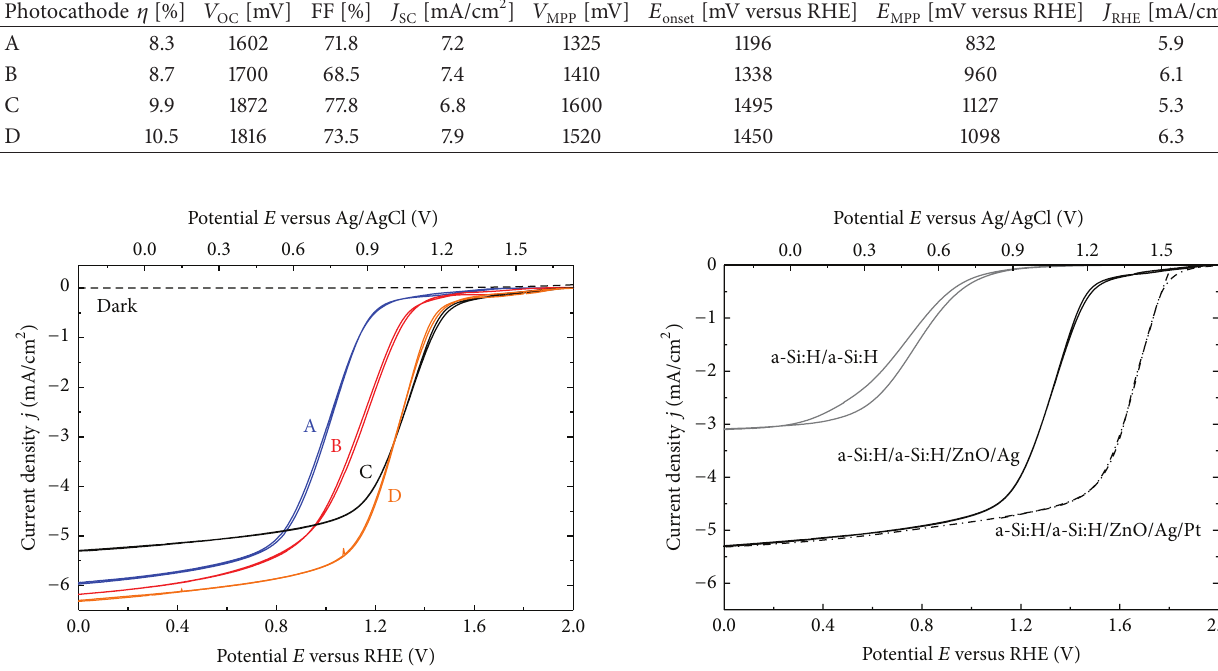
Figure 10: Cyclic voltammetry measurement of a-Si:H/a-Si:H pho- tocathodes with no metallic back contact (solid grey curve), with ZnO/Ag back contact (solid black curve, photocathode C from Table 3) and with ZnO/Ag/Pt back contact (dashed curve), in 0.1M H 2 SO 4 solution (pH 1) under 100mW/cm 2 illumination intensity at a scan rate of 30 mVs −1